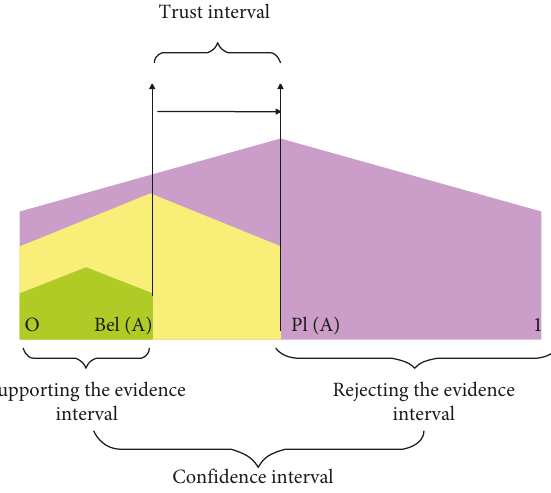
Figure 1: The confidence interval of proposition A. Table 1: Common confidence